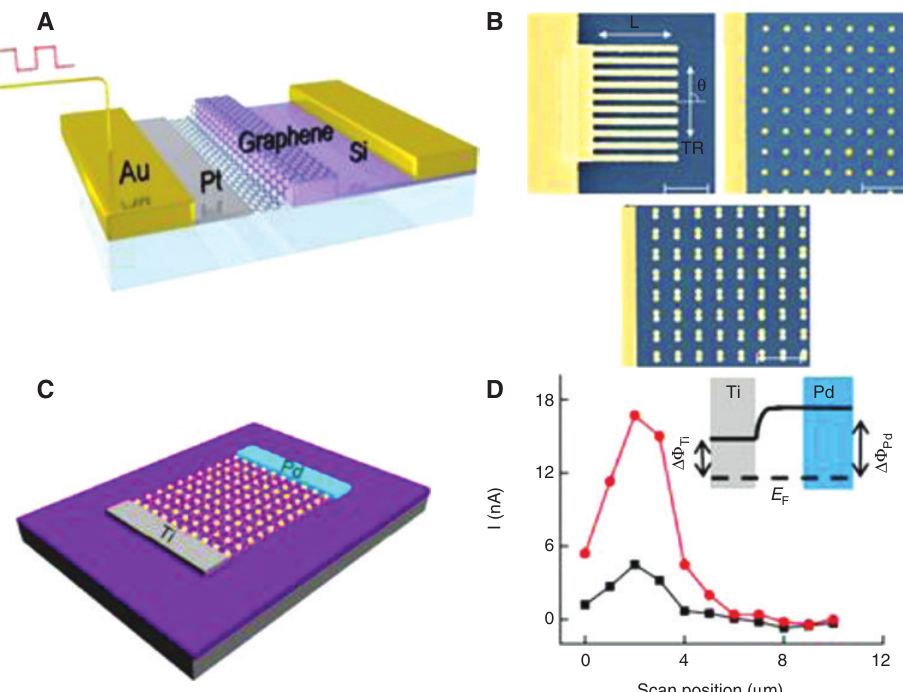
Figure 14: Photodetection enhancement by metallic plasmonics and graphene. (A) Schematic of a monolayer graphene sheet is on top of a silicon bus waveguide [202]. (B) Different metallic structure to enhance the performance of grapheme-based device. Scale bar = 1 μ m [203]. (C) Schematic diagram of a grapheme-based photodetector with asymmetric metal contacts (Ti and Pd) decorated with Au nanostructures. (D) Photocurrent profile with laser scanning from outside of the Ti electrode (black line: normal graphene device; red line: plasmon resonance-enhanced graphene device). The inset shows the band profile of the asymmetric metal-contacted graphene photodetector